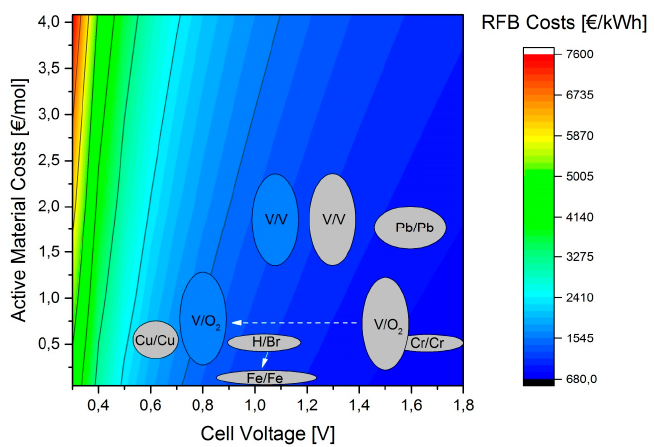
Figure 7. Influence of active material costs and cell voltage on the system costs of a VRFB with a current density of 50 mA/cm².